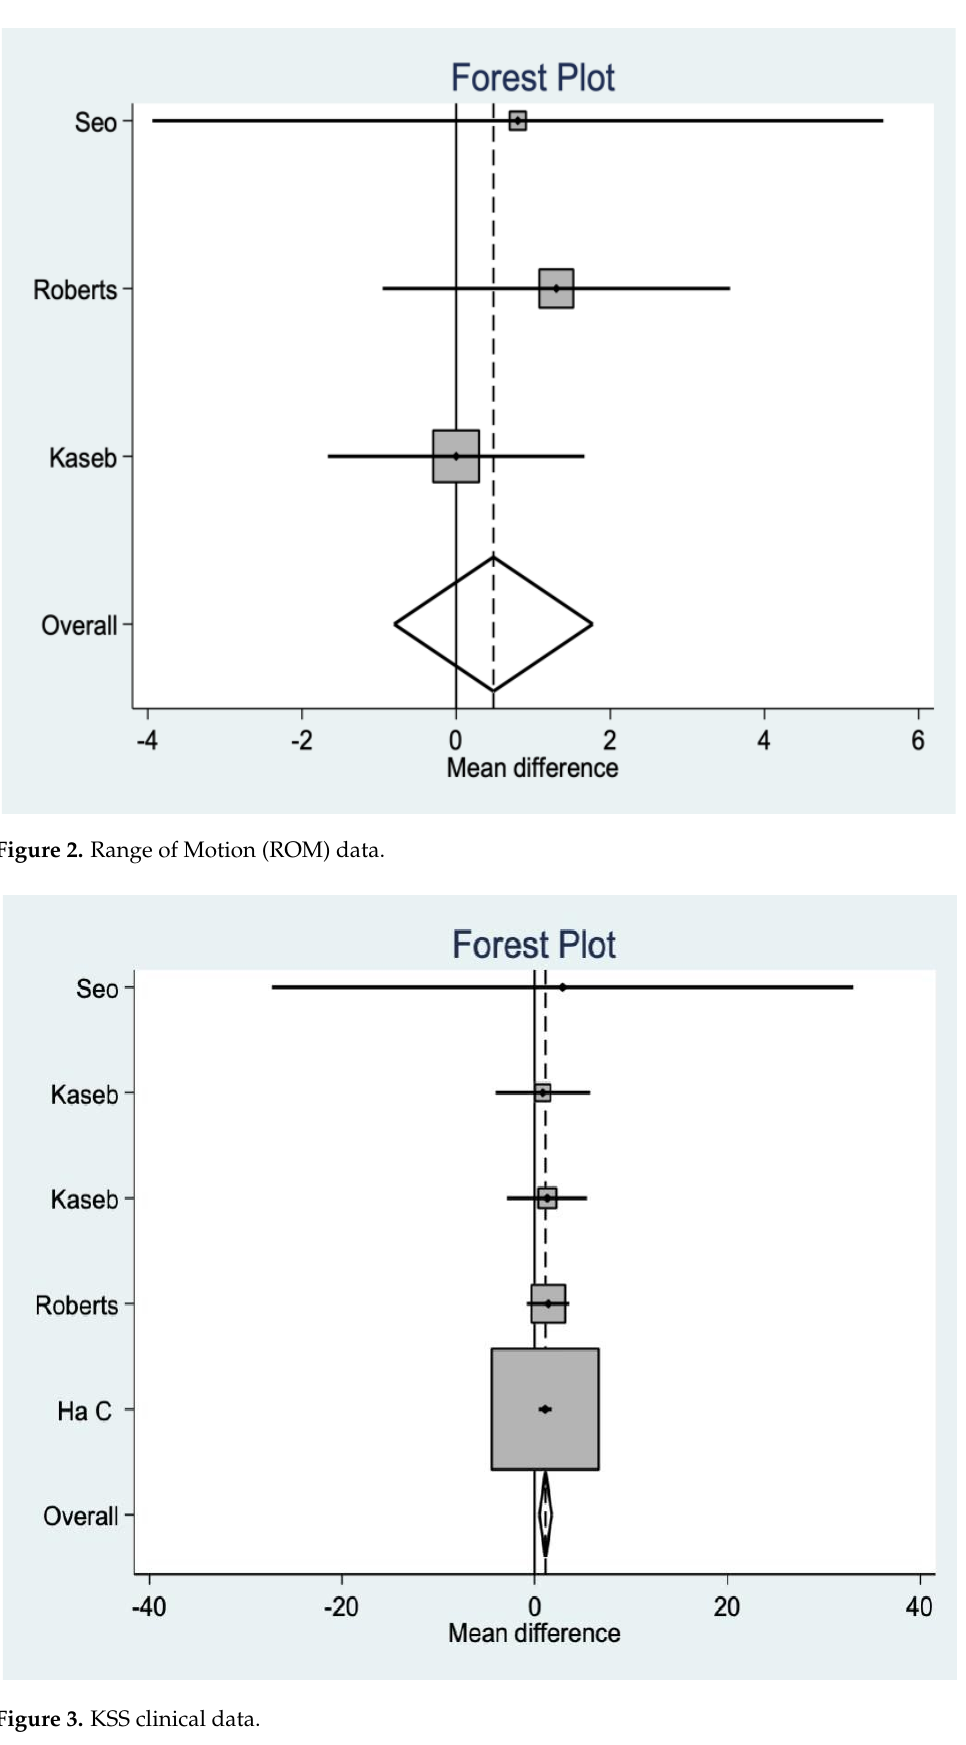
Figure 3. KSS clinical data.